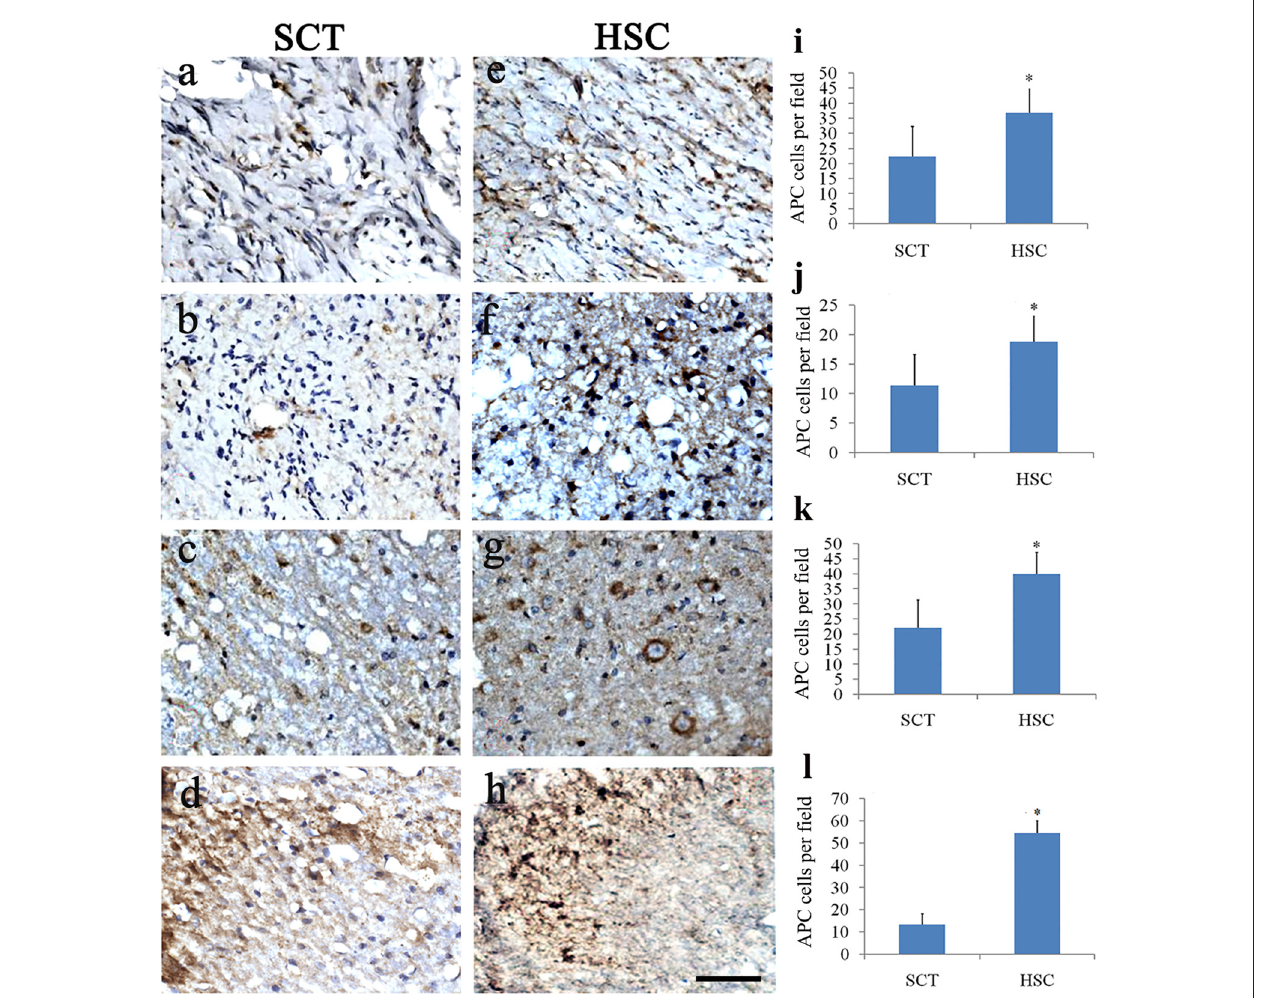
FIGURE 9 | HSC transplantation promoted oligogenesis. Compared with the sham group, the number of APC positive cells was largely decreased in the injured center, rostral and caudal spinal cord near the injured site post SCT (A–D) . Comparatively, the number of oligodendrocytes was effectively increased at 24 weeks post-SCT (E–H) . Quantitative histogram showed that the number of oligodendrocytes in HSC group was higher than that of the SCT one (I–L) . (A,E,I) Scar center; (B,F,J) Posterior Funiculus of rostral scar; (C,G,K) gray matter of rostral scar; (D,H,I) Dorsal horn of caudal scar. Data are presented as the mean ± SD ( n = 7). Student’s t test was used to analyze the data. Data in the sham group were not shown. ∗ P < 0.05 vs. SCT. Bar = 50 µ